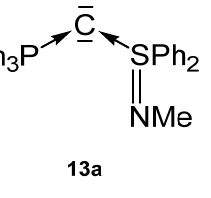
Figure 16. Carbone complexes reported by Fujii et al.